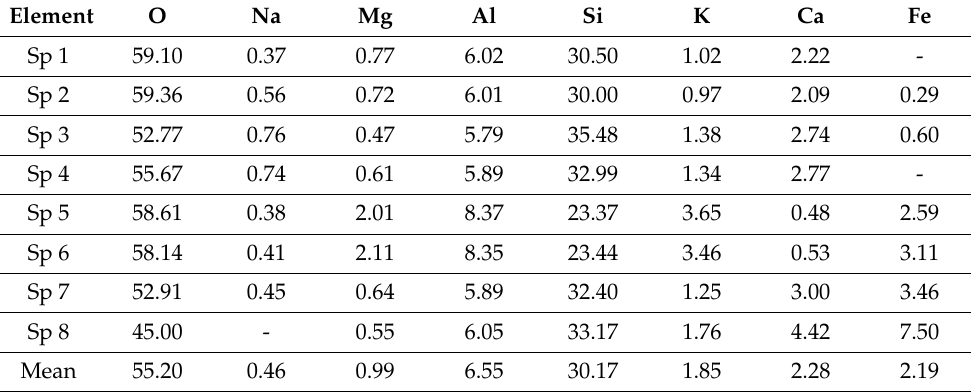
Figure 4. Backscattered electron mode (BSE) images of NZ (left) and SZ (right) with marked eight fields (spectra, Sp) per sample for EDS analysis.